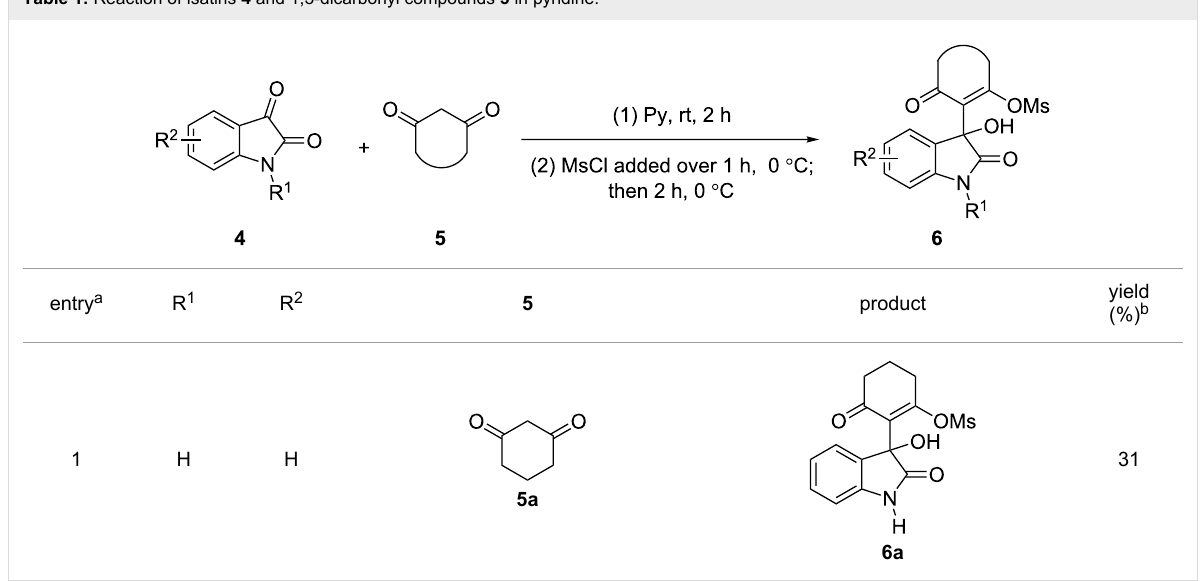
Table 1: Reaction of isatins 4 and 1,3-dicarbonyl compounds 5 in pyridine.